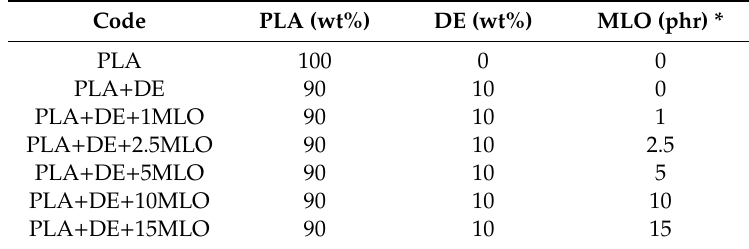
Table 2. Composition and labelling of PLA / DE composites with different amounts of MLO